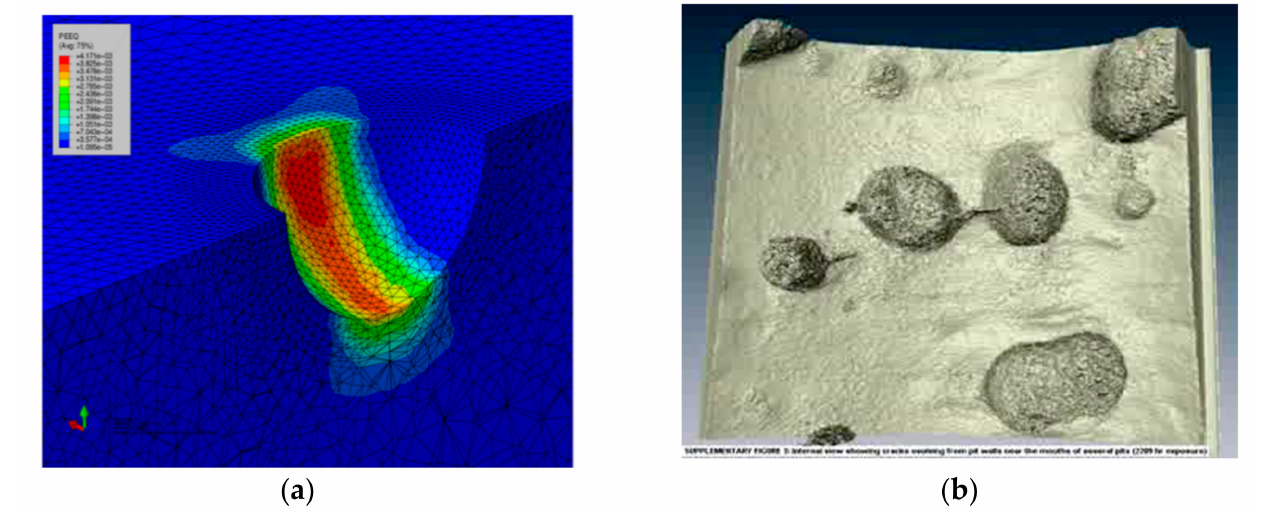
Figure 4. ( a ) FEA modelling of strain localisation in pit. Reprinted with permission from [13] Copyright 2010 Crown Copyright; ( b ) 3D imaging of cracks emerging from pit near the pit mouth using XCT [14]. Figure 4b is copyright Elsevier, 2011, reproduced by